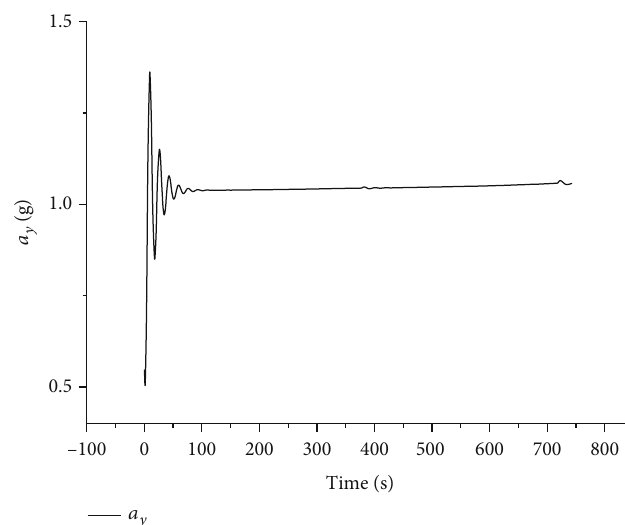
Figure 14: Normal acceleration for the quasiequilibrium glide method.